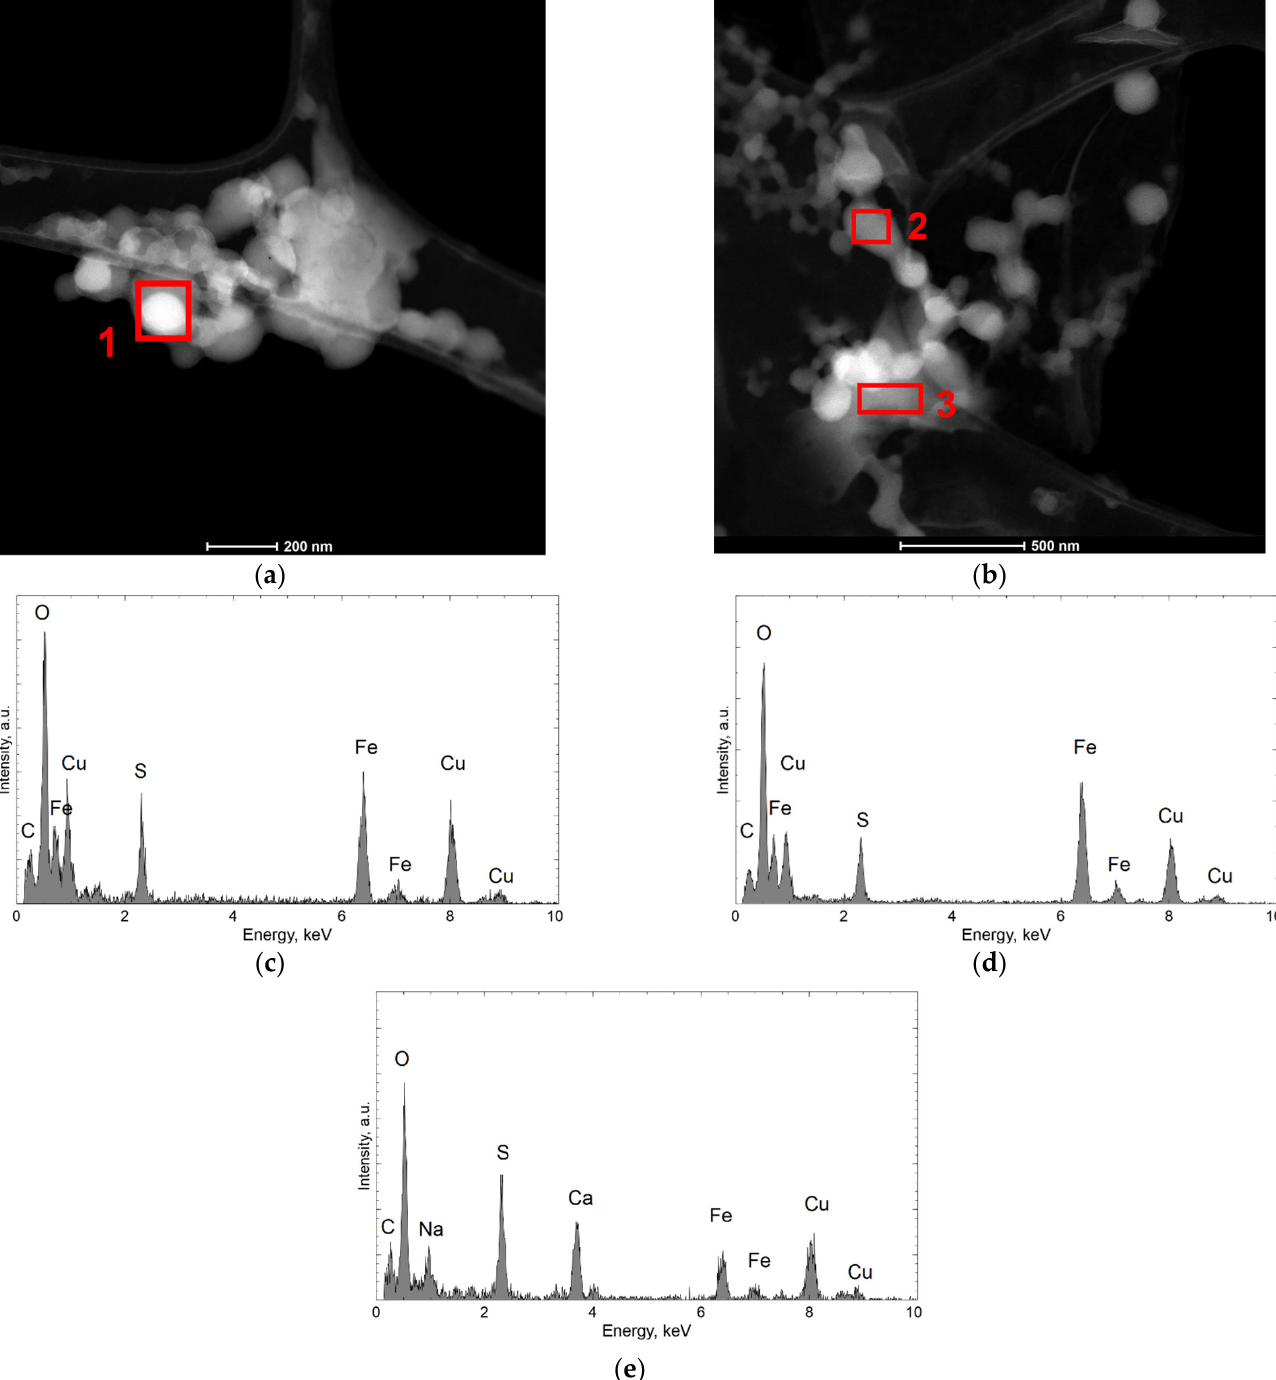
Figure 6. STEM-HAADF images of the dried residues precipitated from leachate, diluted; ( a , b ) spherical particle where EDS analysis were performed, ( c ) EDS result obtained in area indicated by 1 in ( a ), ( d ) EDS result obtained in area indicated by 2 in ( b ), ( e ) EDS result obtained in area indicated by 3 in ( b ).